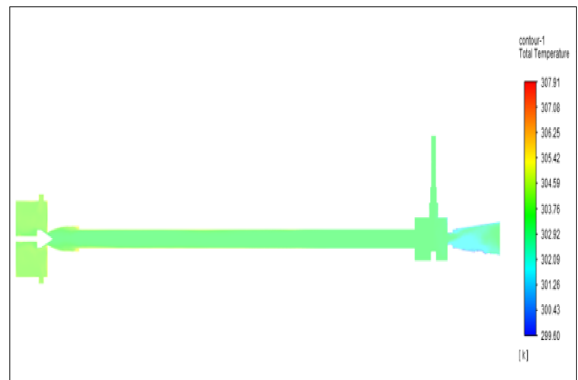
Figure 21. PVC at 6 bar.